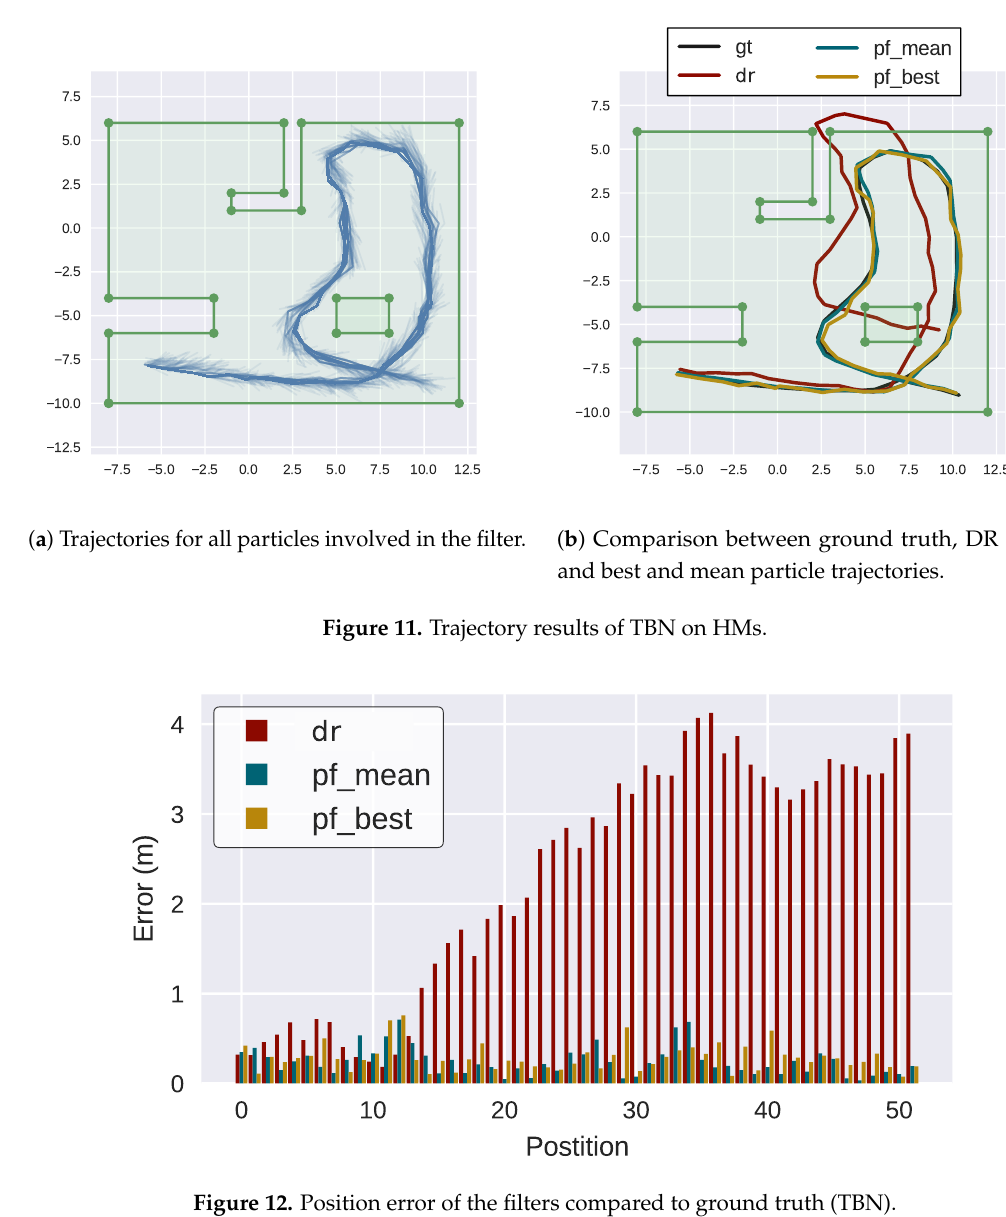
Figure 12. Position error of the filters compared to ground truth